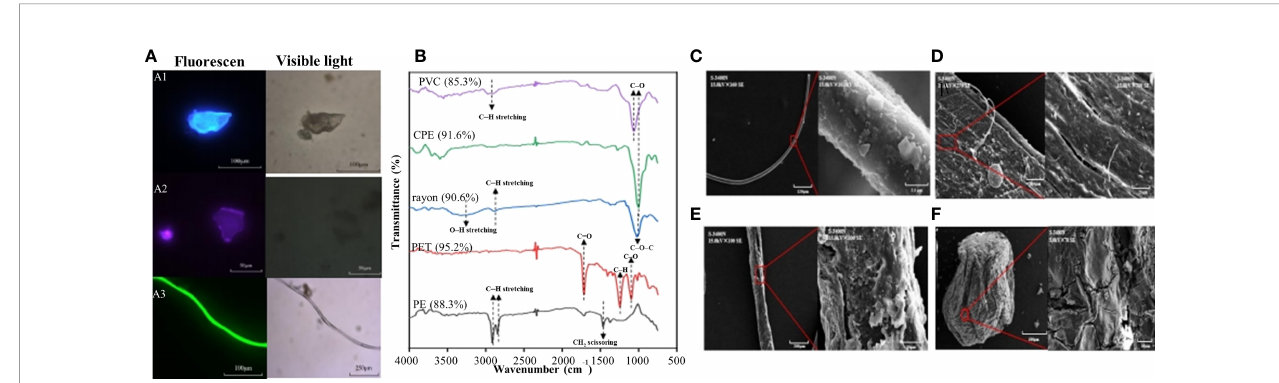
FIGURE 2 | The representative microscopic images of MPs collected from the seawater, sediment and sand samples (A) . The fragment was collected from seawater in AF1 (A1) , the pellet and fi lm were collected from sediment in EL (A2) , and the fi ber was collected from seawater in SD2 (A3) . The representative m -FTIR spectra of MPs collected from the coastal zone (B) . Among them, the PVC was collected from sediment in EL, the CPE and rayon were collected from seawater in SD2, the PET and PE were collected from seawater in AF1. The proportion above each spectral line is the similarity between the target polymer and the standard polymer in the library. SEM images of the representative MPs collected from seawater in sewage discharge area (SD2) (C) and harbor (HB1) (D) , sediment in sewage discharge area (SD2) (E) , and sands in bathing beach (BB2) (F)